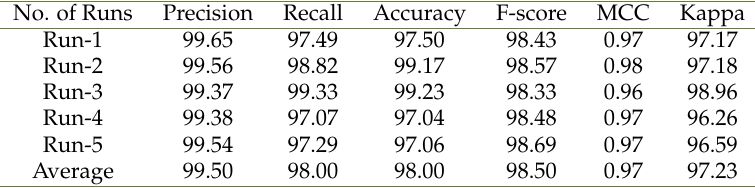
Fig. 3. (a )Result analysis of the EMACC-MR Method on the Activity Recognition Dataset, (b) F-score and kappa analysis of the EMACC-MR Method on the Activity Recognition Dataset Table 2. Result Analysis of Proposed EMACC-MR Method on Pima Indian Diabetes Dataset